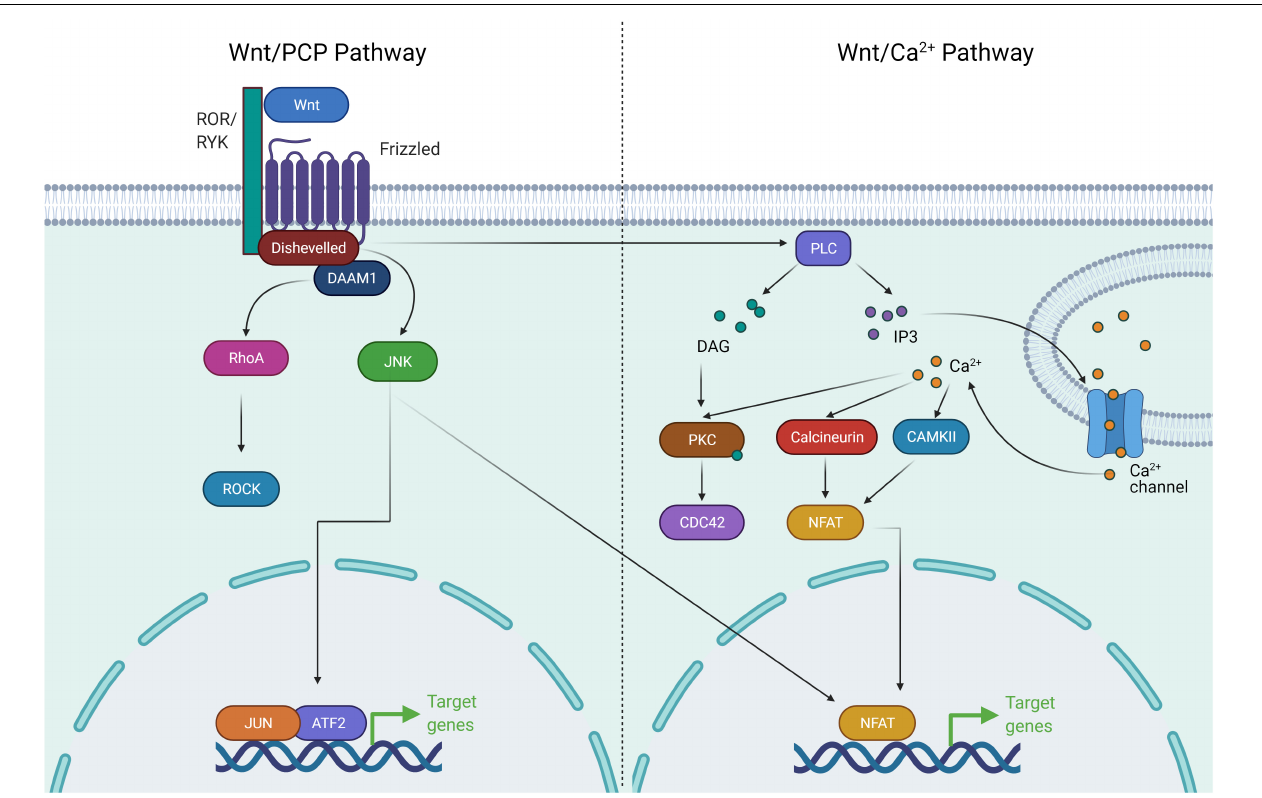
FIGURE 2 | Components of non-canonical Wnt signaling pathway. The non-canonical Wnt pathway is independent of β -catenin. Wnt activation leads to complex formation between ROR and Frizzled which allows activation of Disheveled. Disheveled is then able to activate DAAM1 and RHOA GTPase. RHOA in turn activates ROCK. Activation of ROCK and JNK leads to cytoskeletal remodeling. Wnt/Ca + signaling involves activation of Disheveled upon Wnt activation, followed by activation of PLC. PLC activates the downstream effectors PKC, Calcineurin, and CAMKII via release of Ca + . These factors drive NFAT mediated transcriptional program and cytoskeletal